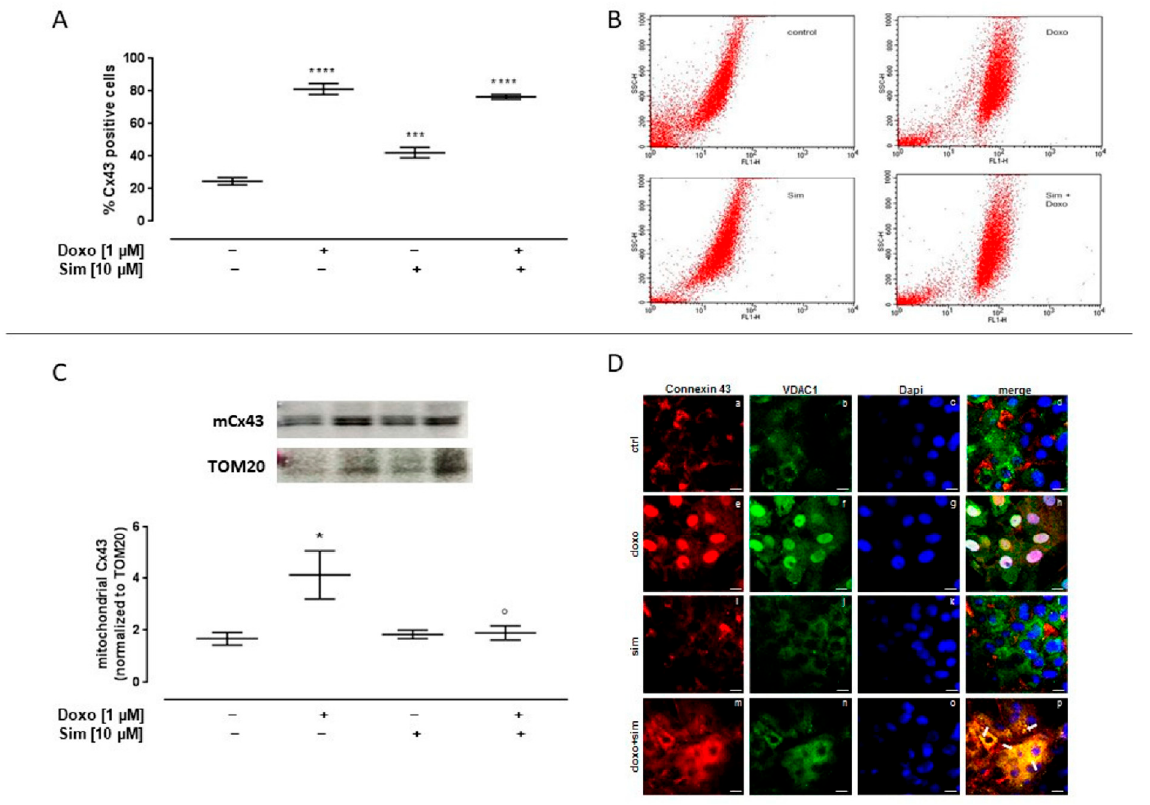
Figure 4. Effect of Simvastatin on intracellular Connexin43 expression. H9c2 cells were pre-treated with Sim (10 µM) for 4 h and then co-exposed to Sim and Doxo (1 µM) for 20 h. Intracellular Cx43 level was detected by flow cytometry analysis. Results are reported as mean ± S.E.M. of Cx43-positive cells’ percentage from at least three independent experiments, each performed in duplicate ( A ). Representative histograms for the flow cytometry analysis ( B ). Mitochondrial Cx43 expression was detected by Western blot analysis, and TOM20 expression was used as the loading control. Results are expressed as mean ± S.E.M from at least three independent experiments, each performed in duplicate (panel ( C ). Cells were stained with Cx43 (red) (panels a , e , i , m ), VDAC1 (green) (panels b , f , j , n ), and nucleus with DAPI (blue) (panels c , g , k , o ) and were determined by immuno fl uorescence analysis (merge in panels d , h , l , p ). Scale bar, 50 µm. A representative of three experiments is shown ( D ). Data were analyzed by variance test analysis, and multiple comparisons were made by Bonferroni’s test. * p < 0.05, *** p < 0.001, and **** p < 0.0001 vs. untreated cells; ° p < 0.05 vs. Doxo-treated cells.